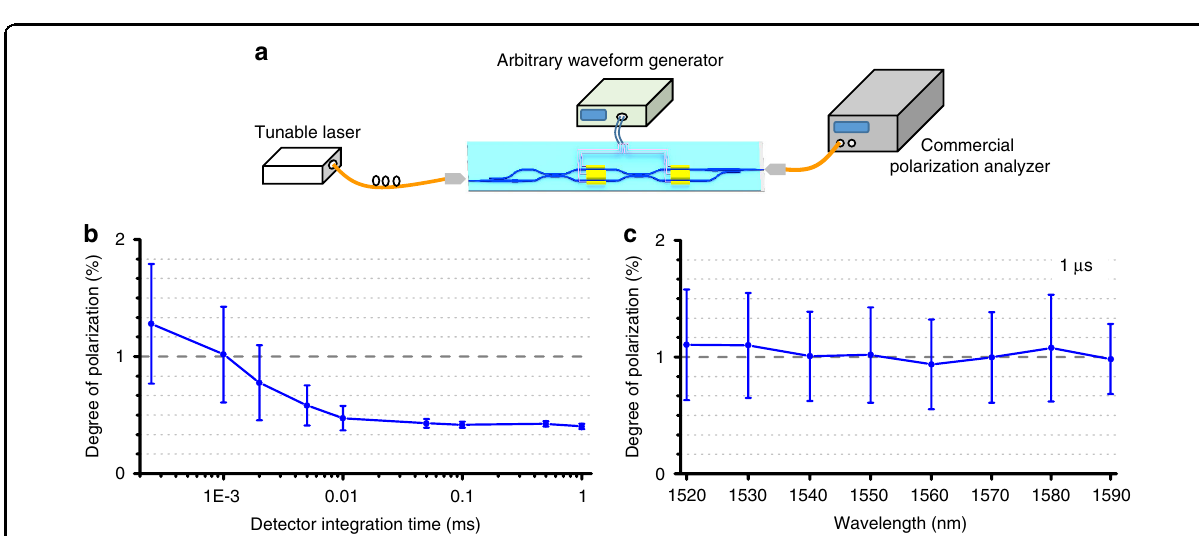
Fig. 3 Performance of the polarization scrambling device. a The experiment setup for characterizing the performance of the polarization scrambling device. b The degree of polarization (DOP) as a function of the detector integration time at a wavelength of 1550 nm. c The DOP as a function of the wavelength when the detector integration time is equal to 1 μ